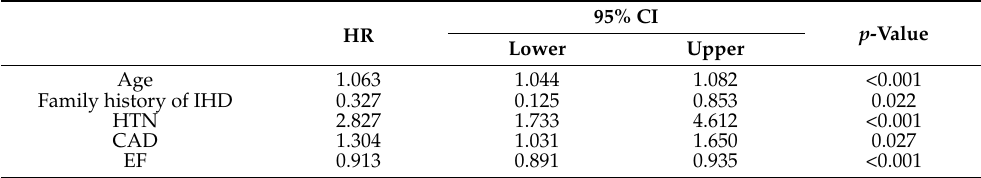
Table 2. Logistic binary regression for no recovery/delayed recovery AKI adjusted for baseline variables found to be significant.